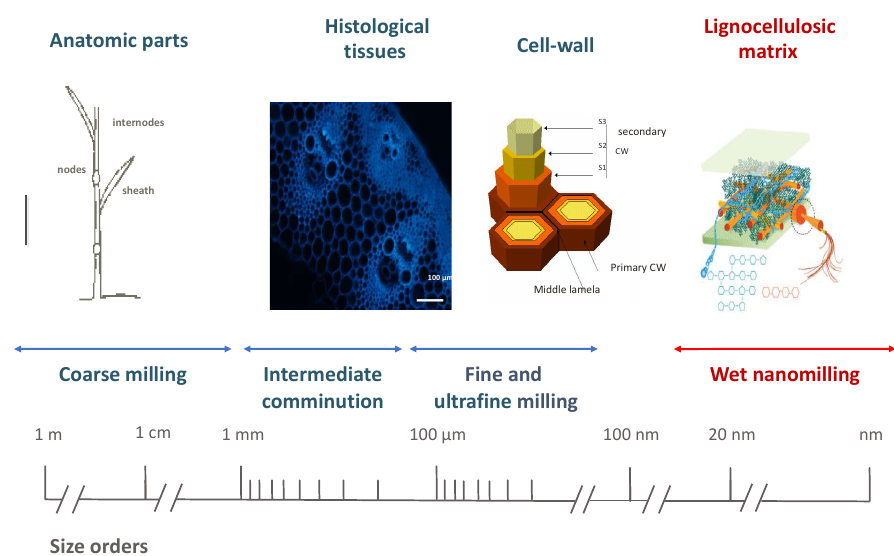
Figure 2. The metric and histological scales of a plant material in relation to the different milling steps.